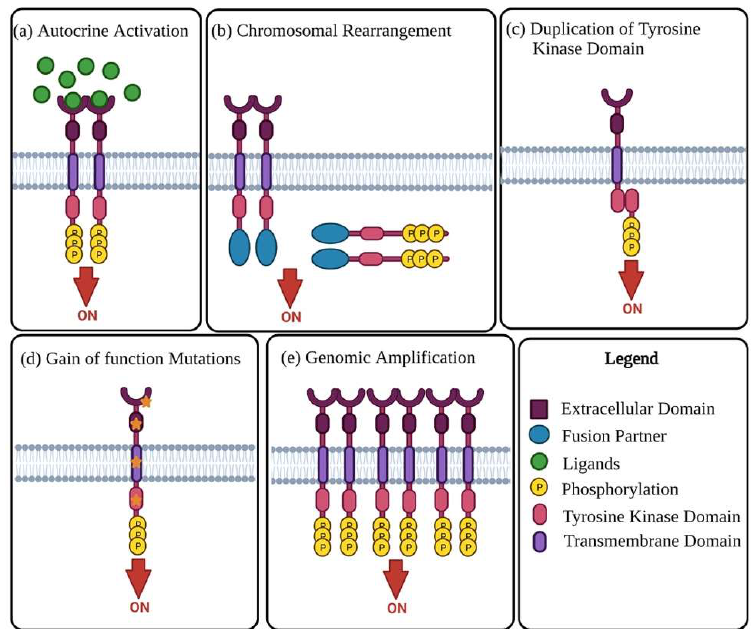
Figure 1. Mechanisms of oncogenic RTK activation. ( a ) Visual representation of autocrine activated RTK signalling . Increased ligand production by cancer cells or the tumour microenvironment causes activation of RTK signalling, leading to increased kinase activity and phosphorylation of the C-terminal tail of the receptor. ( b ) Chromosomal rearrangement results in the creation of a hybrid fusion oncoprotein composing partly of the TK and fusion partner. These RTK fusion partners are often cytoplasmic or membrane bound proteins depending on the position of the genomic cut-off point. The rearrangement results in deletion of regulatory domains, which then causes tyrosine kinase activation. ( c ) Duplication of tyrosine kinase domain could result in the formation of an intramolecular dimer and activation of RTK, in the absence of ligands. ( d ) Diagrammatic illustration of probable gain-of-function mutations in several RTK subdomains. Mutations in these regions lead to constitutive activation of the RTK, more often than not in the absence of ligands. ( e ) Visual representation of RTK genomic amplification is frequently a consequence of the genomic amplification of RTK genes, resulting in the increase of local concentrations of